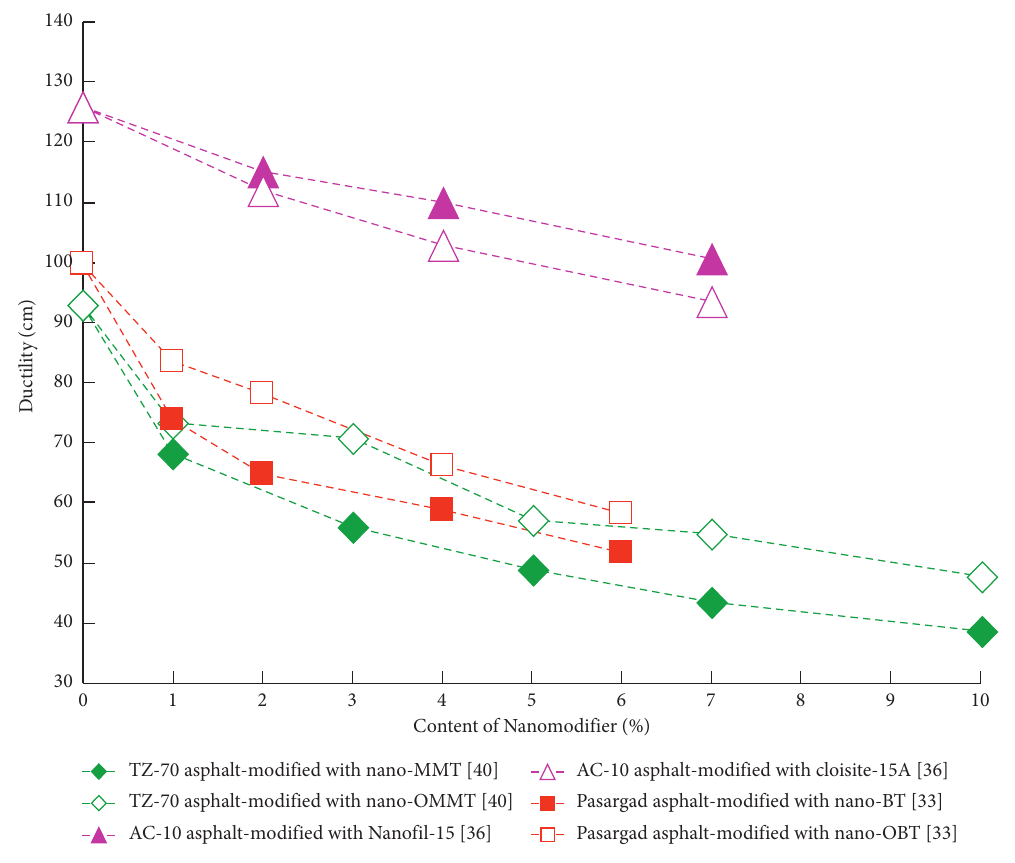
Figure 6: Ductility of nanomodified